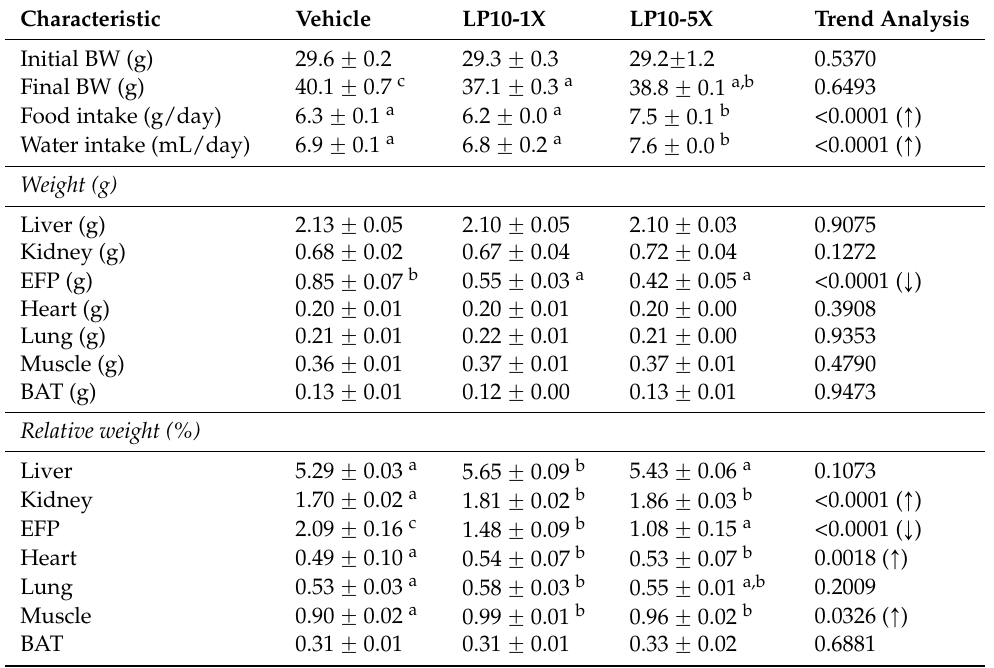
Table 1. General characteristics of mice with Lactobacillus plantarum TWK10 (LP10) supplementation.